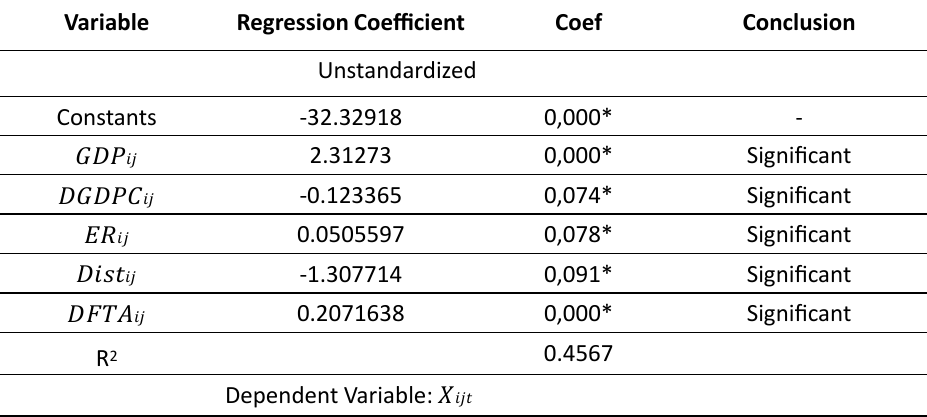
Table 1. Random Effect Regression